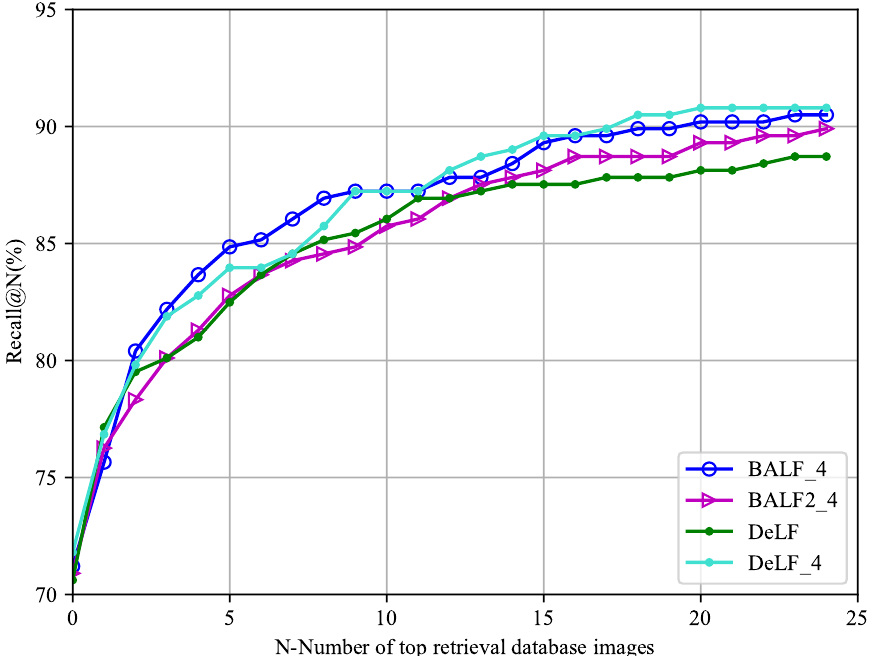
Figure 10. Positioning effect of best 4 experiments measuring by Recall@N. BAF_4 showed best performance in front position, and DeLF_4 showed best performance in back position.